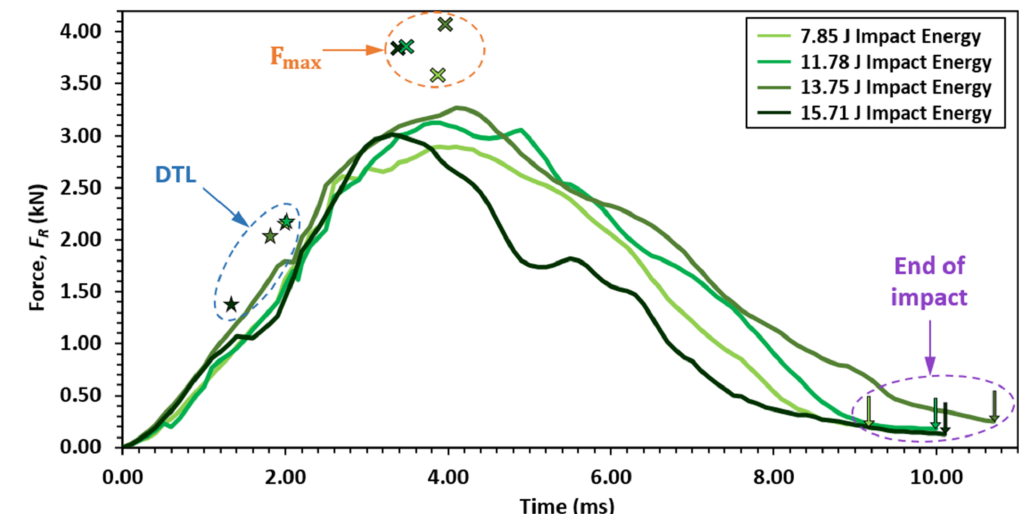
Figure 13. Force–time plot for impact energies of 7.85, 11.78, 13.75 and 15.71 J for an unloaded specimen using a five-point moving average trendline. The stars, crosses and arrows indicate the damage threshold level (DTL), peak force ( F max ) and the end of the impact event (impact duration), respectively.